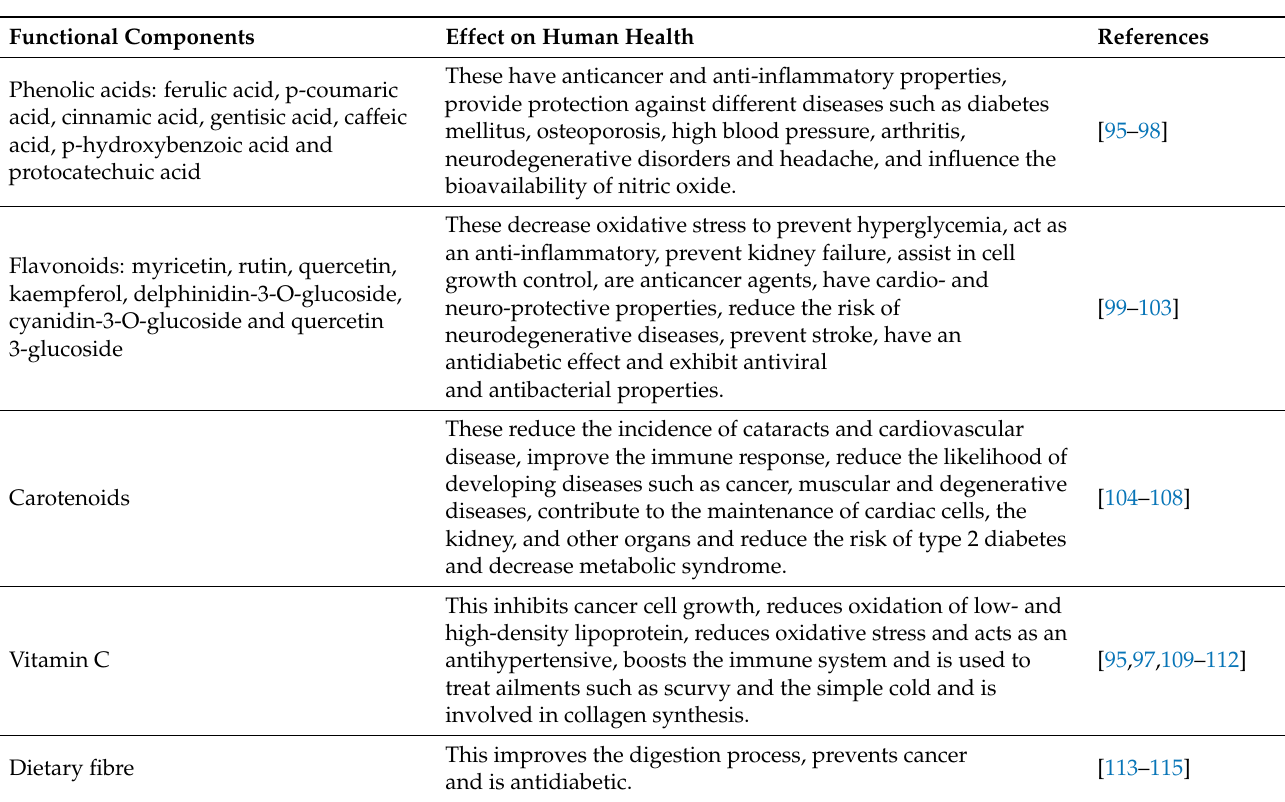
Table 3. Functional components of indigenous leafy vegetables and their impact on human health. Functional Components Effect on Human